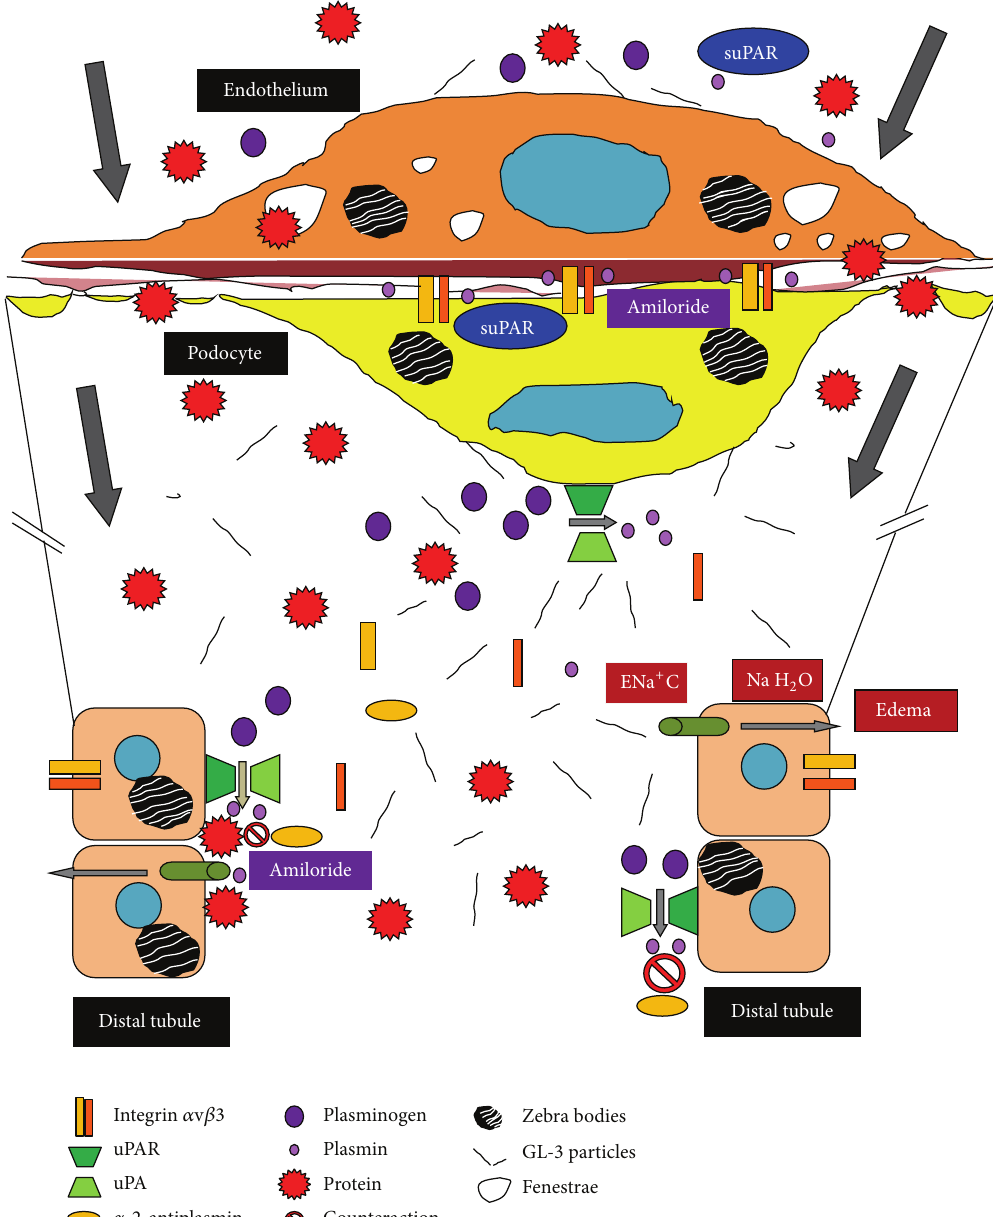
Figure 1: Molecular mechanisms of proteinuria in Fabry disease and amiloride